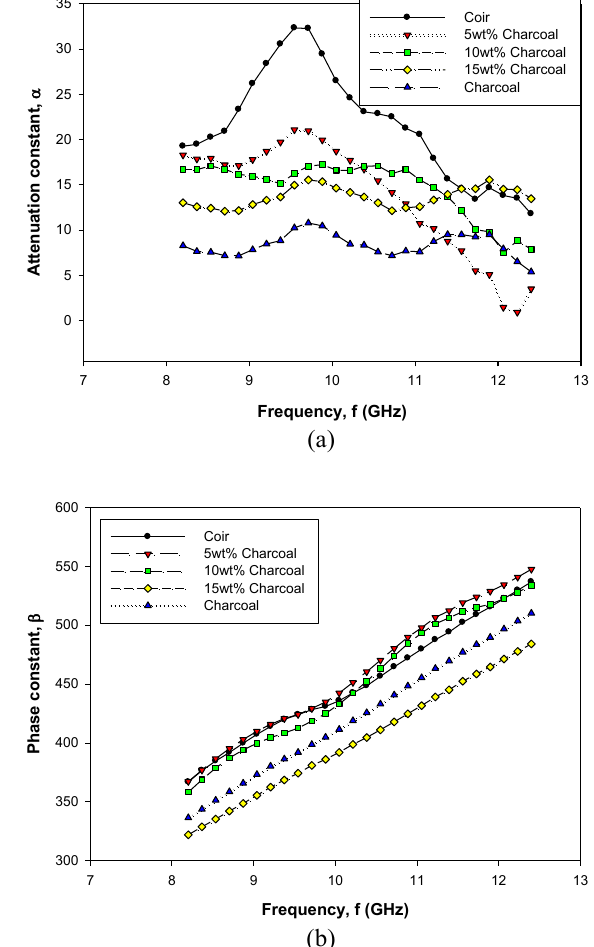
Figure 9: Comparison of the five samples over the x-band frequency for (a) attenuation constant (b) phase